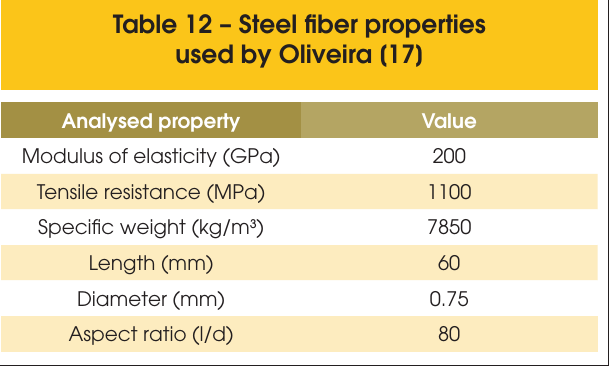
Table 12 – Steel fiber